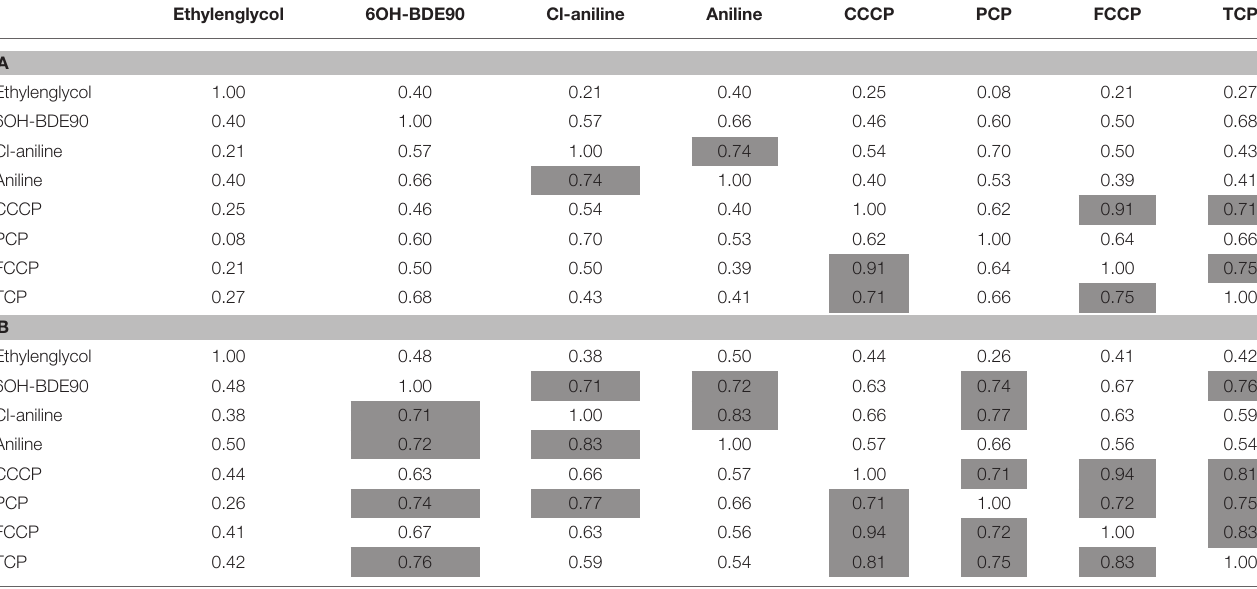
(A) For the 5000 genes with the highest variation. (B) For the most significantly regulated genes. Correlation coefficients above 0.7 are marked with gray background.